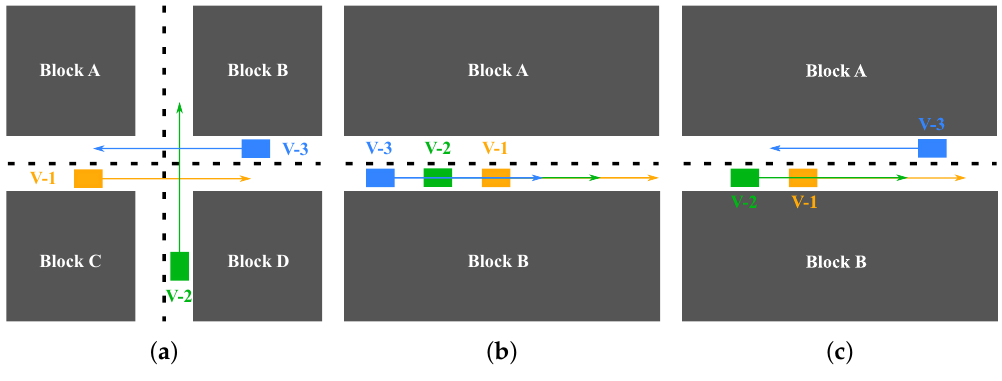
Figure 5. Sketch of three different collaborative scenarios ( a – c ), carried out during the